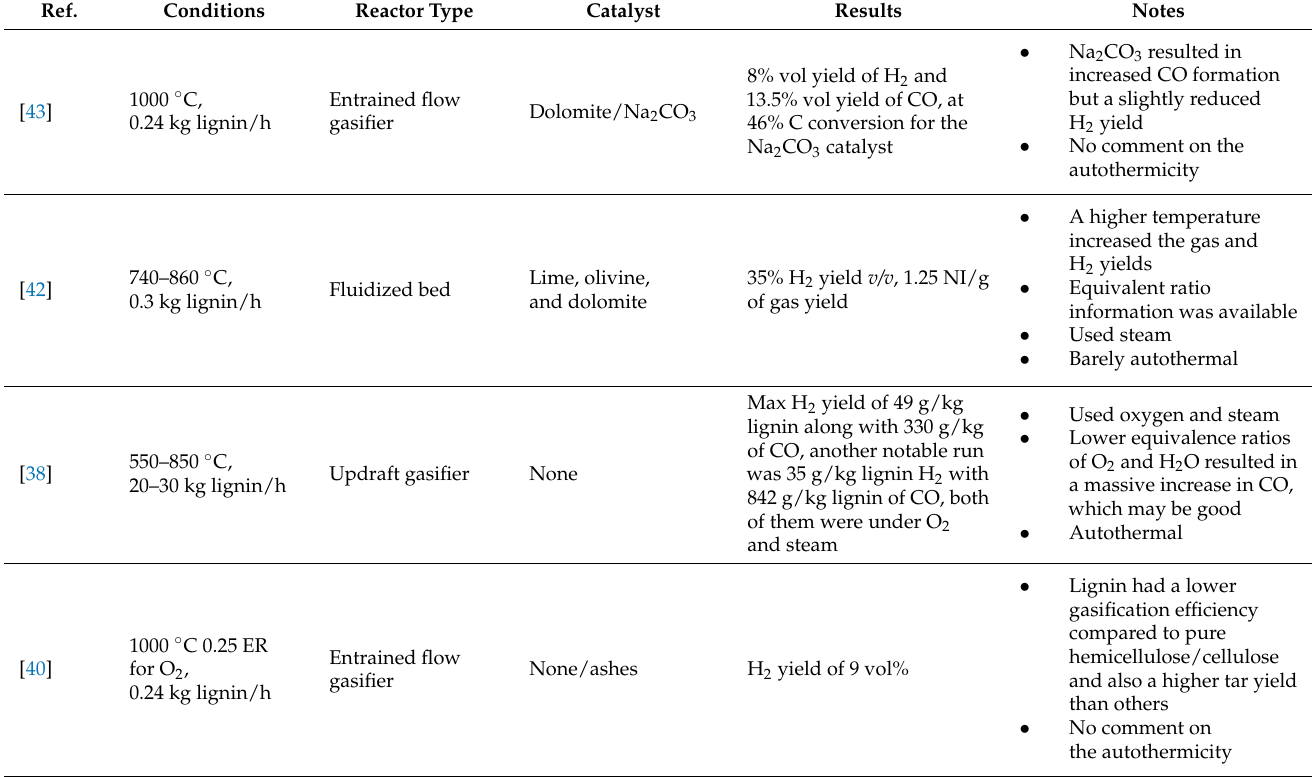
Table 3. Comparison of the found oxidative lignin gasification